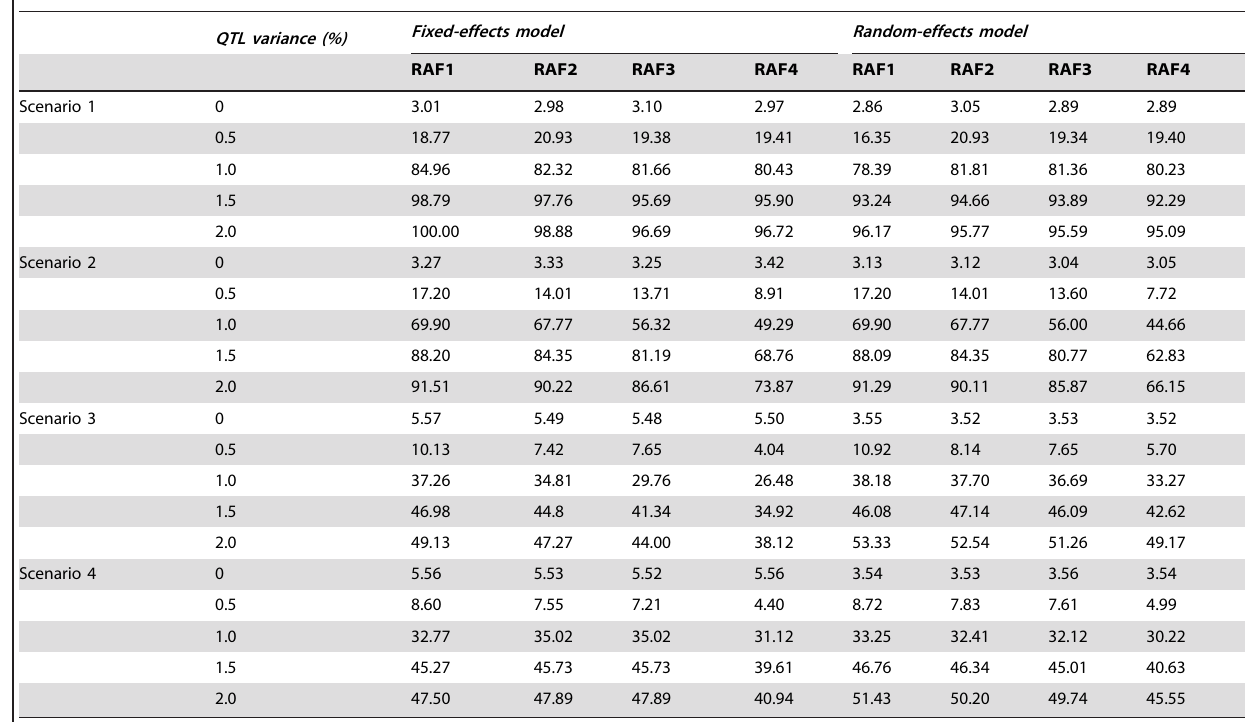
Table 3. Mean power and type-I error rate of Z meta ( a = 10 2 7 ).